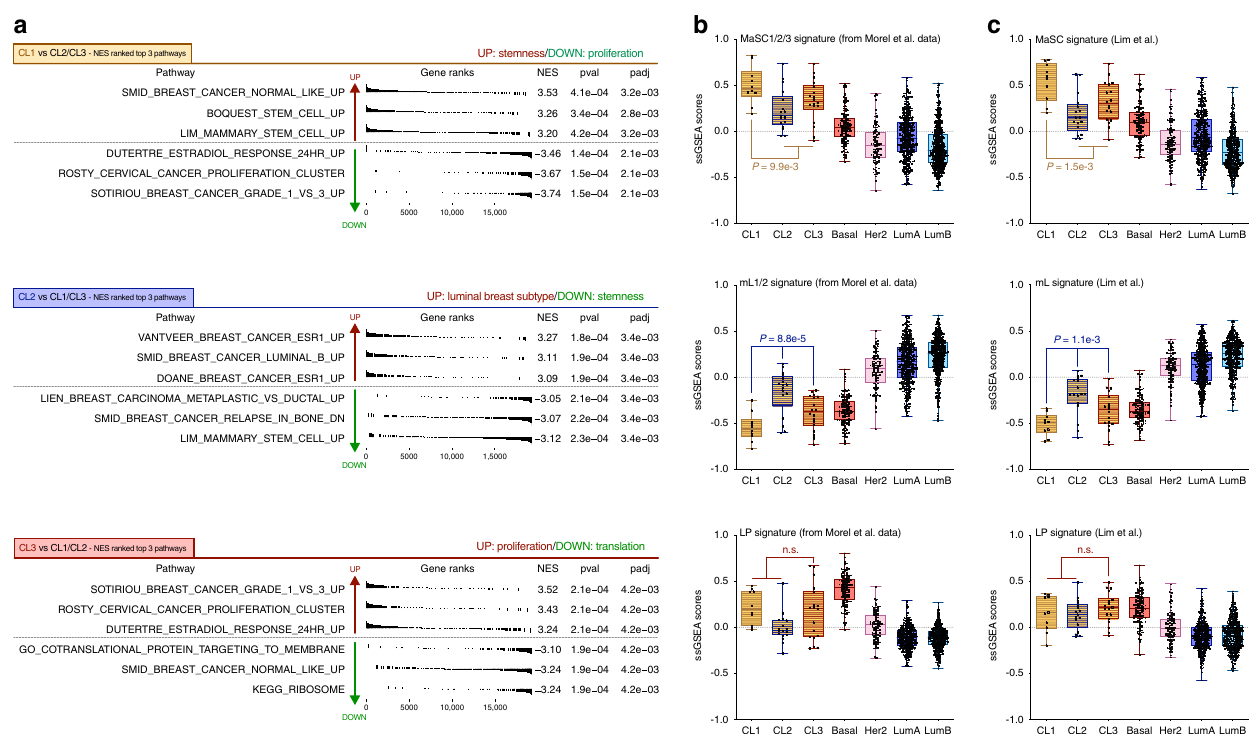
Fig. 3 Claudin-low subgroups show distinct gene expression signatures relative to their differentiation status. a GSEA comparing global gene expression of each claudin-low subgroup from the METABRIC cohort to the two others. The three pathways with the highest and lowest enrichment scores are represented (>15,000 tested pathways — NES ranking). b , c Gene expression analysis for each molecular subtype of ( b ) MaSC1/2/3, LP, and mL1/2 transcriptomic signatures (generated from Morel et al. 18 data) and ( c ) previously published MaSC, LP, and mL transcriptomic signatures (from Lim et al. 14 publication). The CL1 subgroup displays strong stemness features, whereas CL2 and CL3 present luminal- and basal-like transcriptomic characteristics, respectively. Wilcoxon tests. Boxplot: center line, median; box limits, upper and lower quartiles; whiskers, minimum to maximum; all data points are shown. Basal tumors ( n = 129); HER2 tumors ( n = 102); luminal A tumors ( n = 461); luminal B tumors ( n = 429); CL1 tumors ( n = 10); CL2 tumors ( n = 17); CL3 tumors ( n = 18). GSEA: gene-set enrichment analysis; LP: luminal progenitor; MaSC: mammary stem cell; mL: mature luminal; NES: normalized enrichment